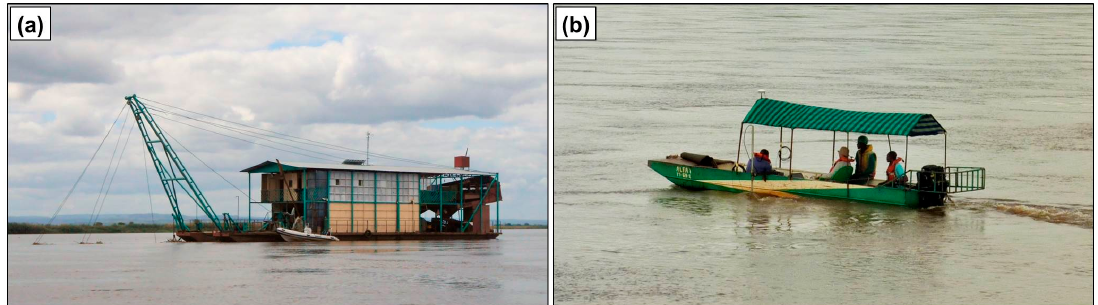
Figure 4. ( a ) The Rio Bravo dredging platform. ( b ) Operations on board the Alfa1 vessel.